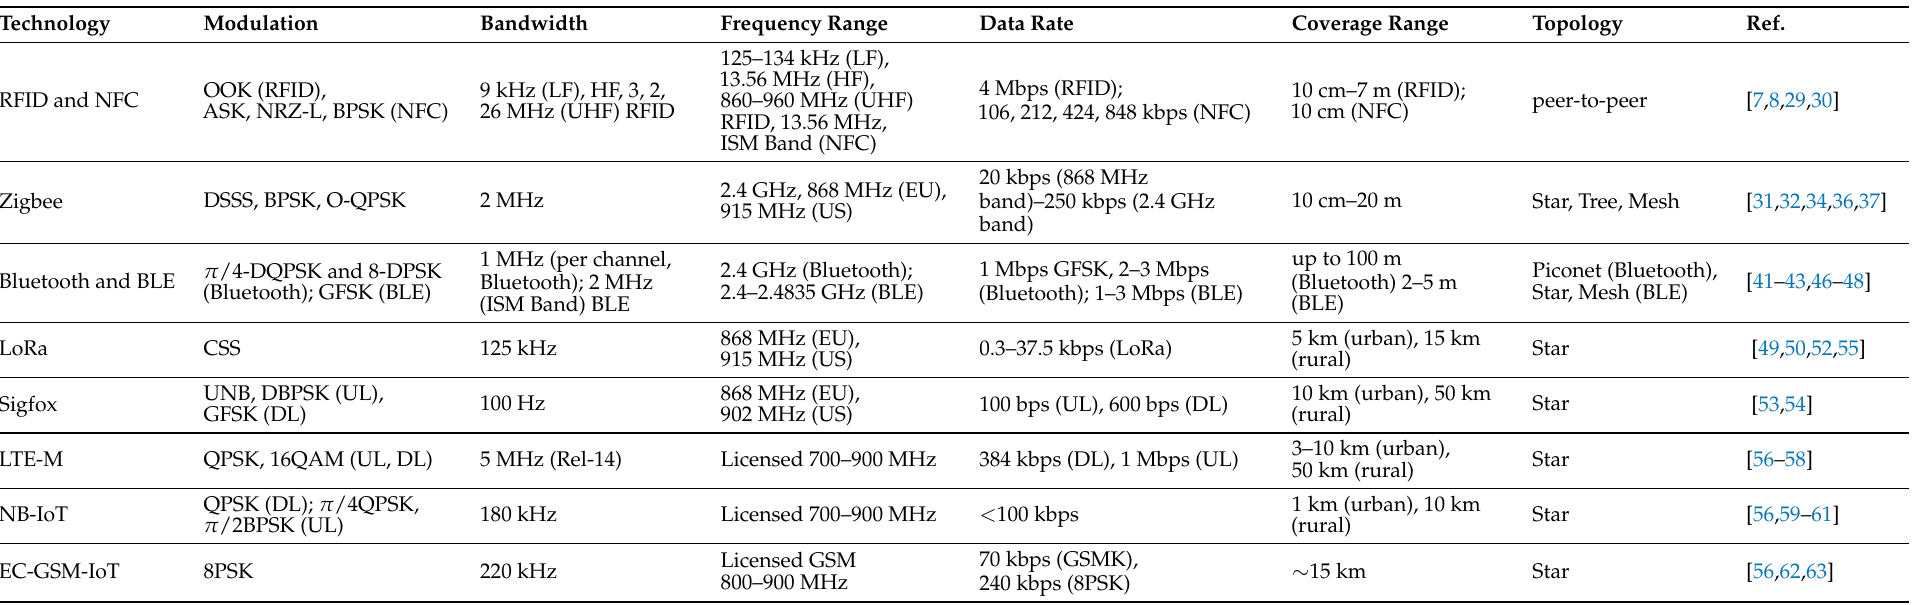
Table 2. LPSAN and LPWAN